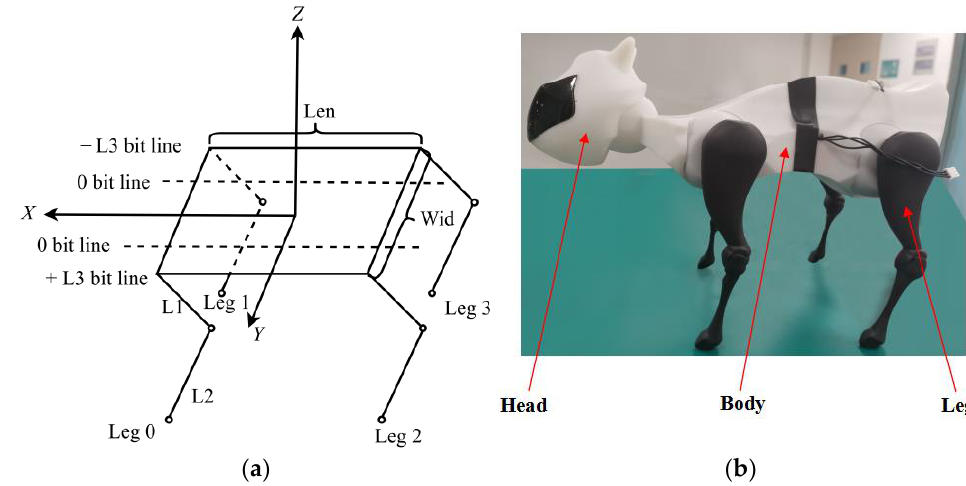
Figure 9. Small quadruped robot. ( a ) Simplified model and parameters and ( b ) Material object.